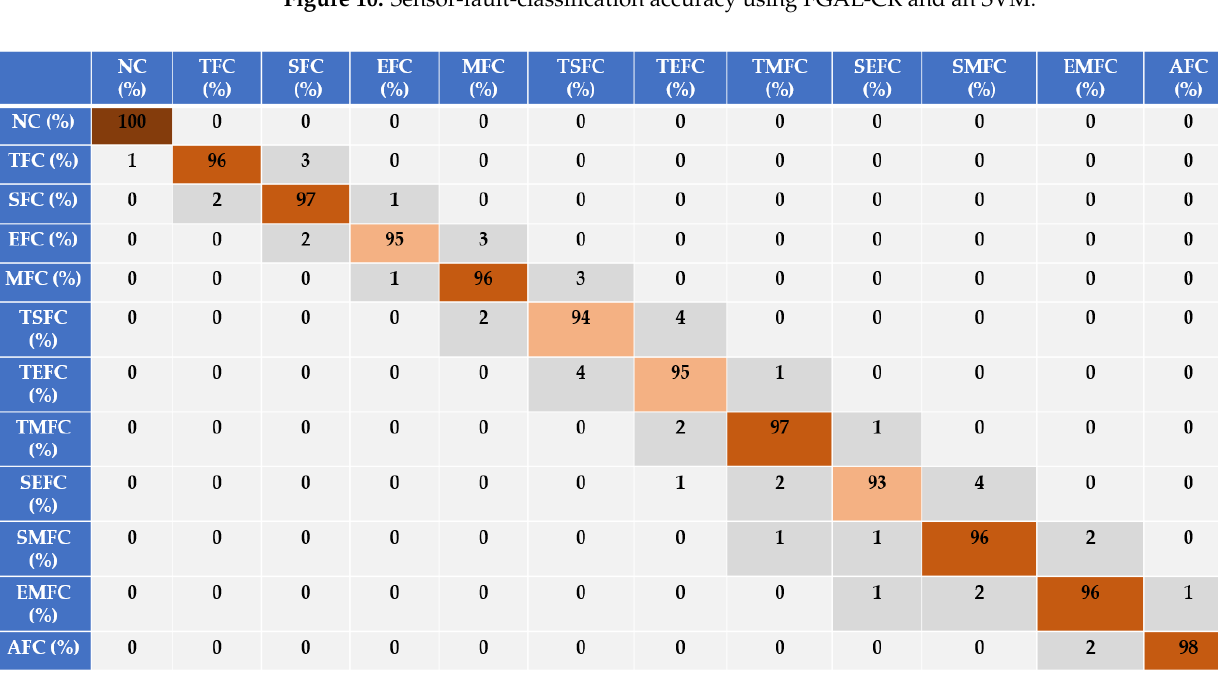
Figure 12. Sensor-fault-classification accuracy using the proposed FGAL-FLCR and an SVM. To reduce the effect of uncertainties, the fuzzy logic approach was used for this step. The combination of the computed fuel ratio observer, Lyapunov approach, and fuzzy technique results in the increase in signal classification accuracy. The average accuracy of the resampled RMS residual signals for air-to-fuel ratio classification using the proposed FGAL-FLCR and SVM was 98.17%. Based on Figures 10–12, the proposed FGAL-FLCR and SVM improved the average accuracy of the resampled RMS residual signals for sen- sor state classification by 8.37% and 2.17%, compared to FGAL-CR with SVM and FGAL- LCR with SVM, respectively. Moreover, to test the robustness of the proposed FGAL- FLCR, FGAL-CR, and FGAL-LCR methods, we processed the training and test data 20 times randomly and found the average accuracy from classification each time. Figure 13 shows the robustness tests of FGAL-CR, FGAL-LCR, and the proposed FGAL-FLCR.